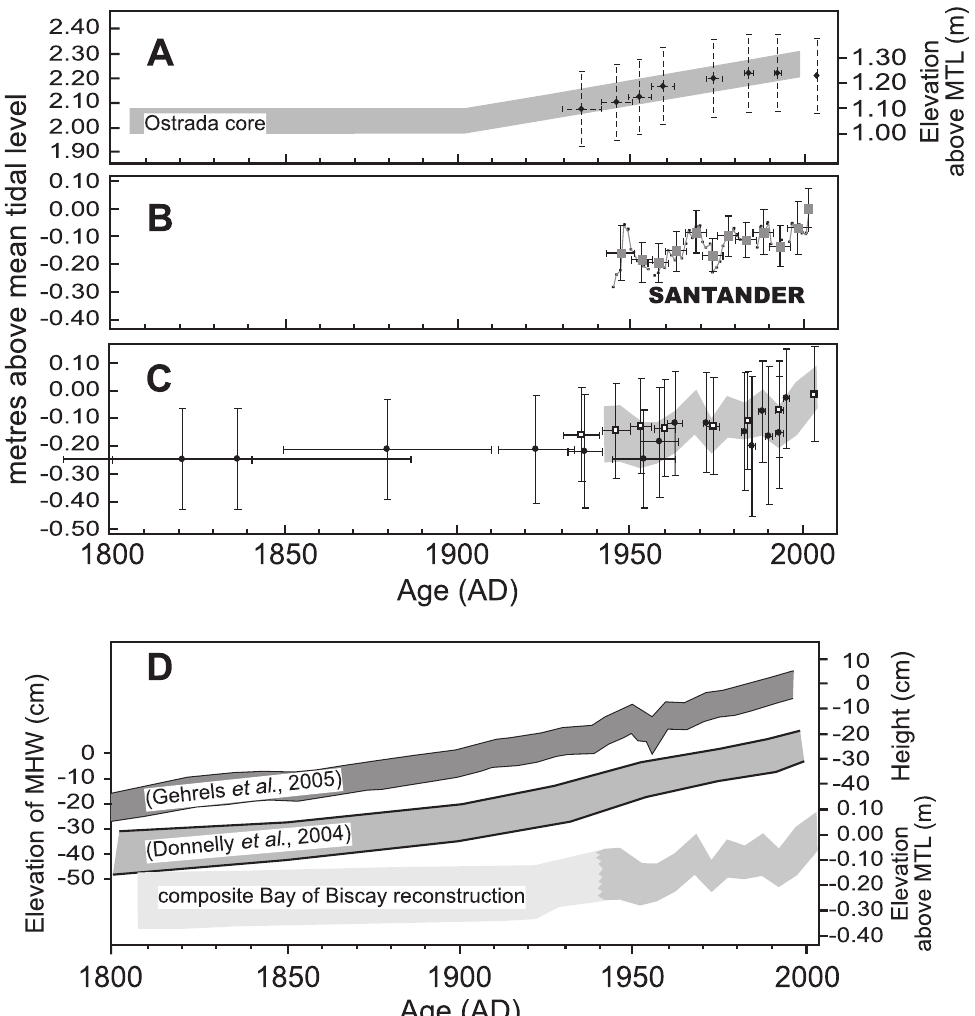
Fig . 3. – relative sea-level curve for the muskiz core (Barbadun estuary) derived from both the reconstruction of the elevations produced by the transfer function and the age model chronology. Key: a-muskiz sea-level reconstruction with assigned errors and the ostrada (Plentzia estuary) sea-level trend (derived from regression analysis, 95 % confidence; Leorri et al ., 2008a). B- annual and five-year sea-level obtained from the Santander tide gauge (data obtained from the Permanent Service for mean Sea Level website). C- Comparison between the sea-level index points (derived from both ostrada cores [circles] and muskiz cores [squares]) and the Santander tide gauge (envelope based on the five-year reconstruc- tion). d-Comparison between the composite reconstruction of sea-level (sea-level index points and instrumental data) and sea-level general trends from northeastern north atlantic: dark grey-Gehrels et al . (2005), light grey-donnelly et al .